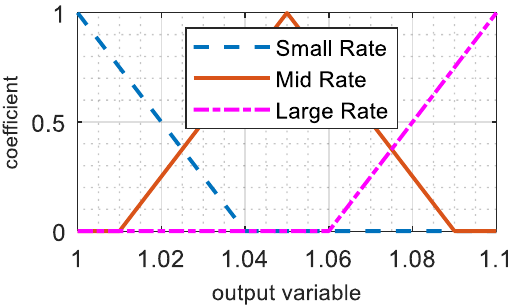
Figure 3. Fuzzy logic vehicle speed estimator output variables based on wheel speed.